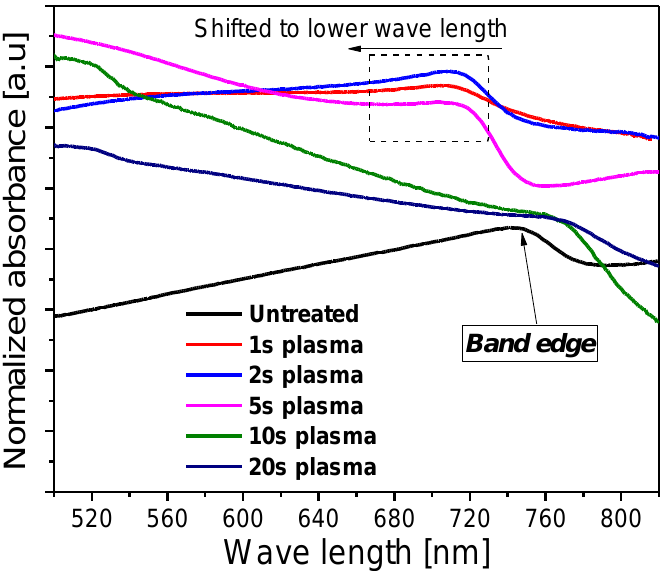
Figure 2. UV–VIS absorbance spectra of the mixed-halide perovskite film before and after plasma treatment. Secondary onset (SE onset) and valance bands of the perovskite films were measured by UPS; the results appear in Figure 3 and Figure S3, respectively.